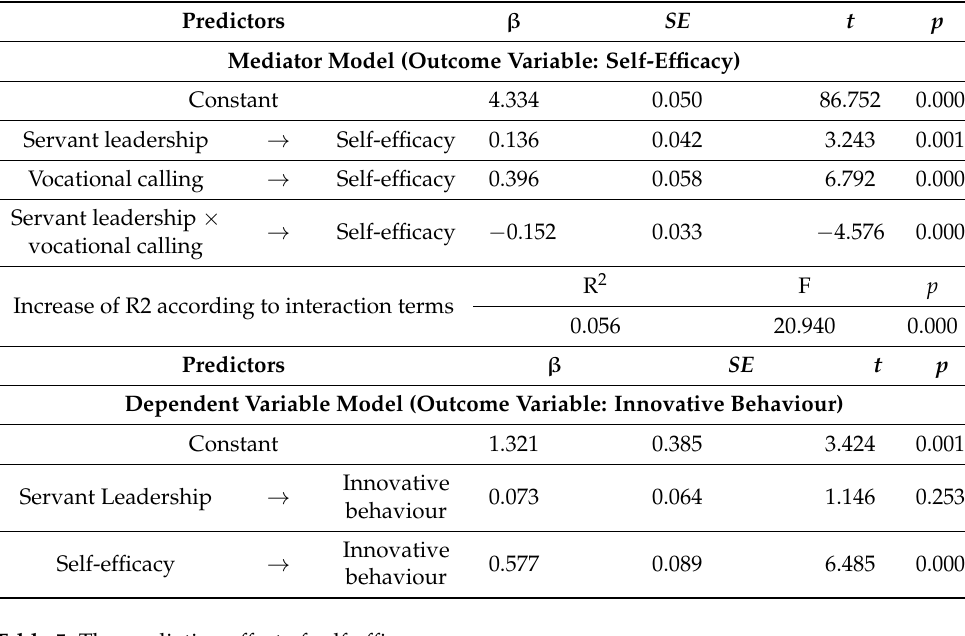
Table 5. The mediating effect of self-efficacy.